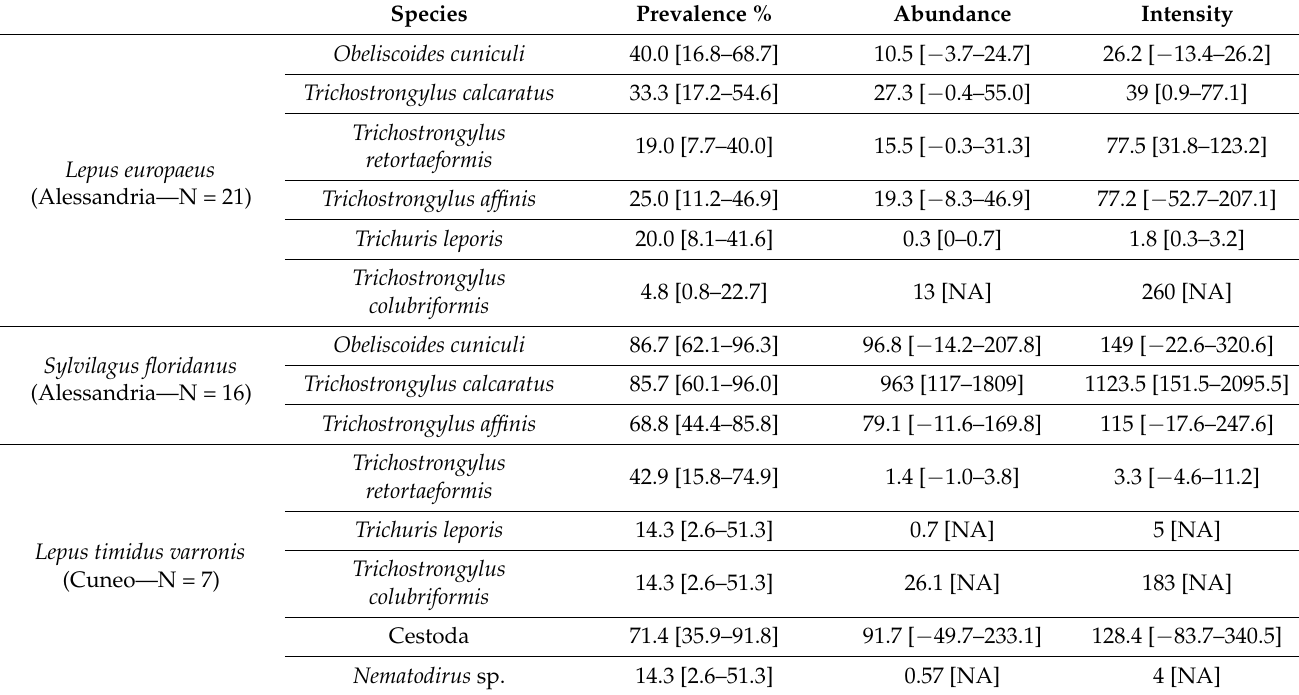
Table 1. Parasite community prevalence, abundance and intensity, by host species and sampled province. Confidence intervals (CI) at 95% is provided in squared brackets.